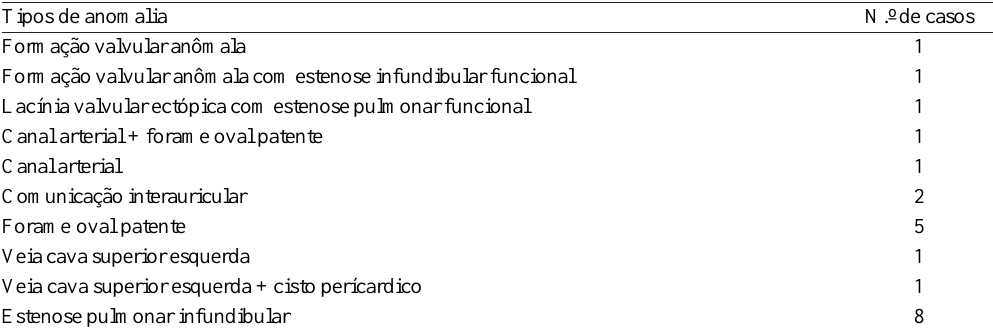
Tabela 1. Anomalias associadas a defeitos do septo ventricular (22